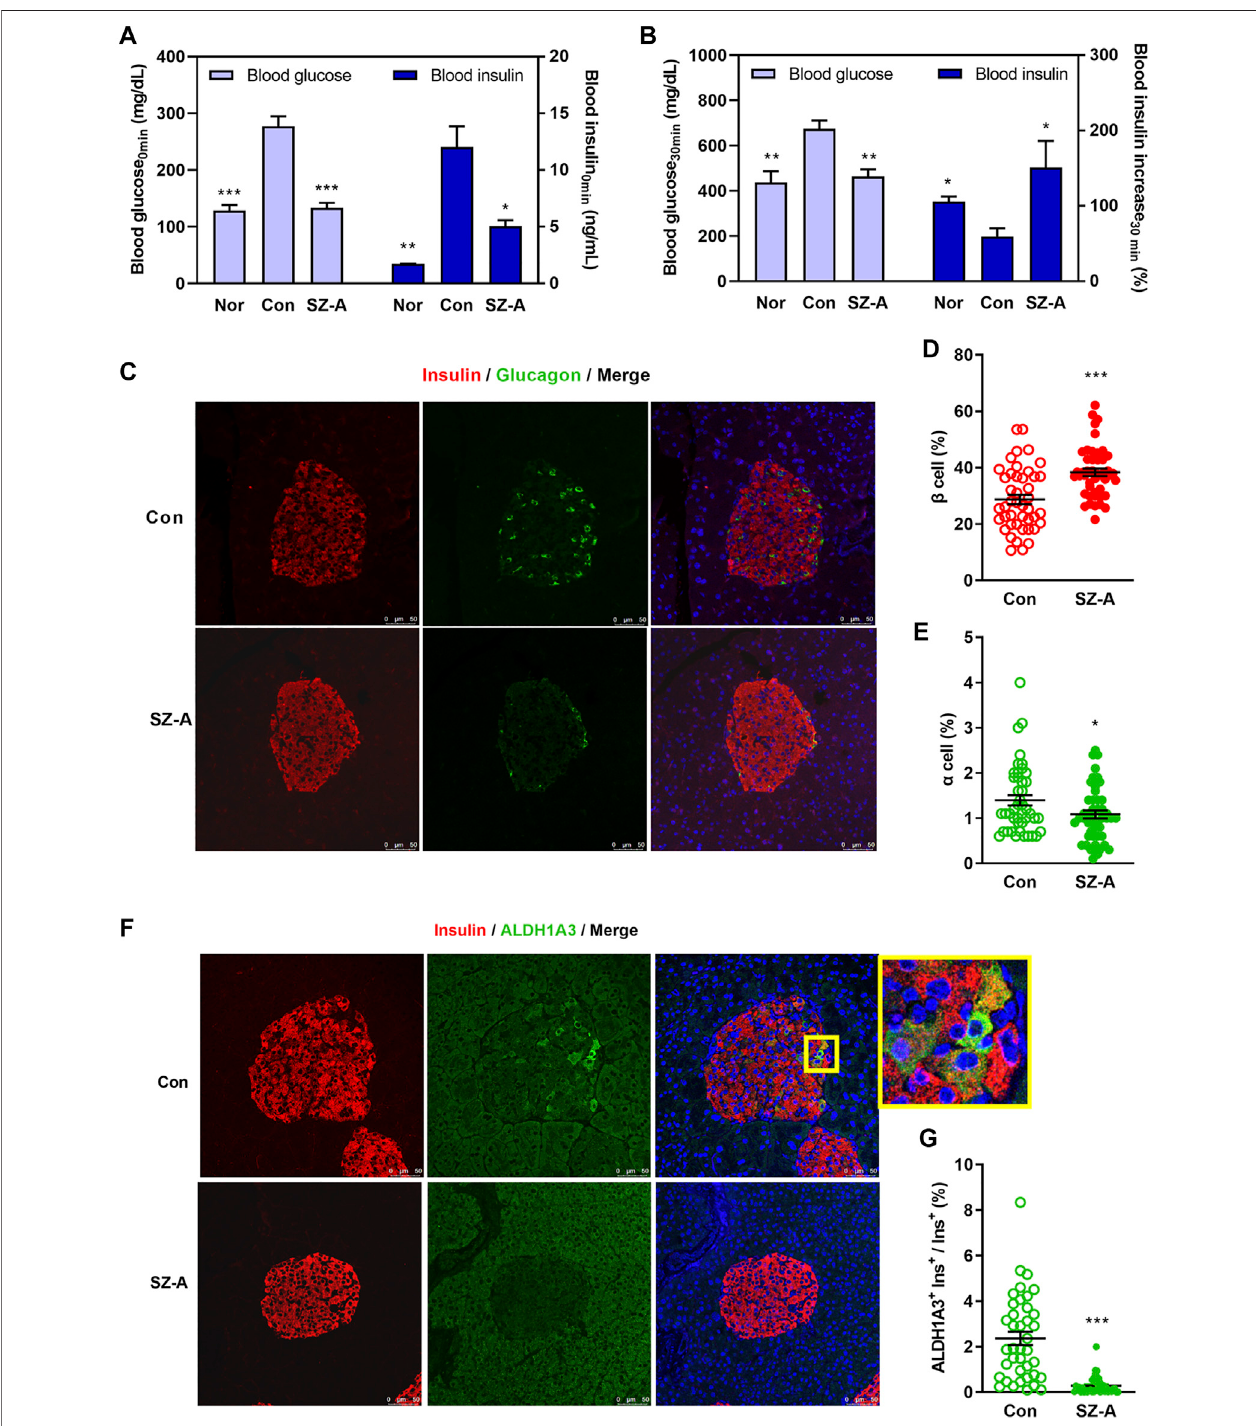
FIGURE 2 | SZ-A amended β -cell dysfunction in type 2 diabetic KKA y mice. (A,B) An intraperitoneal glucose-stimulated insulin secretion test (IPGSIST) was executed in KKA y mice after treating with SZ-A (200 mg/kg) for 8 weeks ( n = 5 mice per group). (A) Blood glucose and insulin levels at 0 min before injection of glucose. (B) Blood glucose and the percentage of increased blood insulin at 30 min after glucose (2.0 g/kg) load. (C – G) Immunohistochemistry of the pancreas of KKA y mice in the Con group and SZ-A (200 mg/kg) group ( n = 5 mice per group). β Cells were labeled with insulin antibody (red), α cells were labeled with glucagon antibody (green), dedifferentiated cells were labeled with ALDH1A3 antibody (green). (D) The percentage of β -cell/islet area; (E) the percentage of α -cell/islet area; and (G) the ratio of ALDH1A3-positive β cells/ β cells. All data are expressed as the mean ± SEM. * p < 0.05, ** p < 0.01, *** p < 0.001, vs. the Con